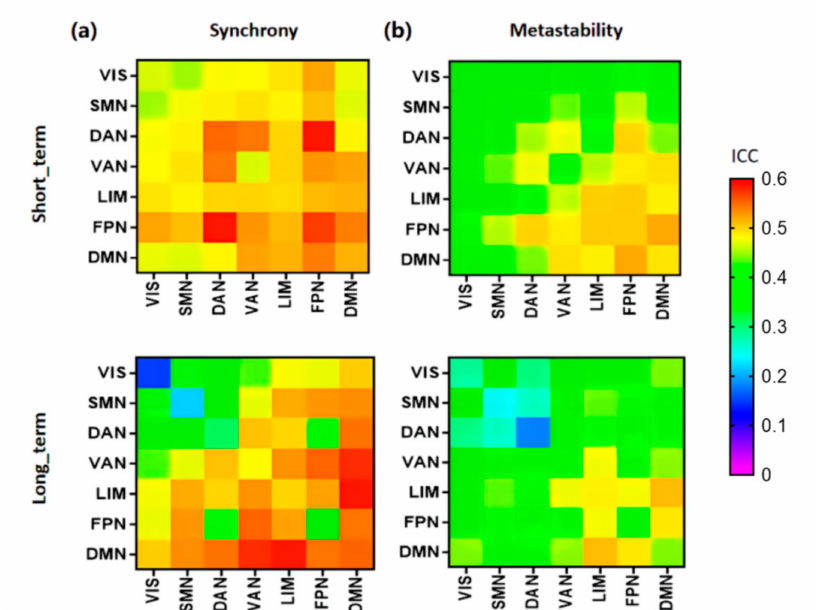
Figure 8. Reliabilities of interaction matrix of synchrony ( a ) and metastability ( b ), evaluated by the intraclass correlation coefficient (ICC). Color bar: